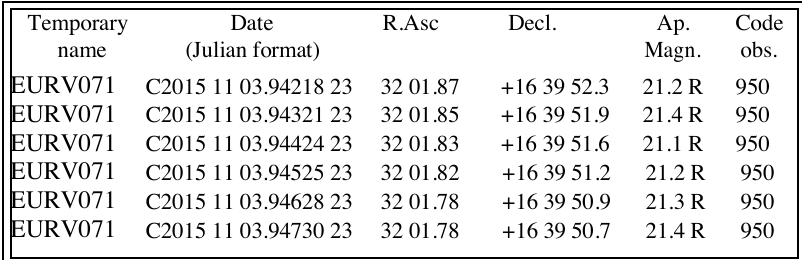
Table 1. The centralized identification data in format MPC (Minor Planet Center) for a new asteroids